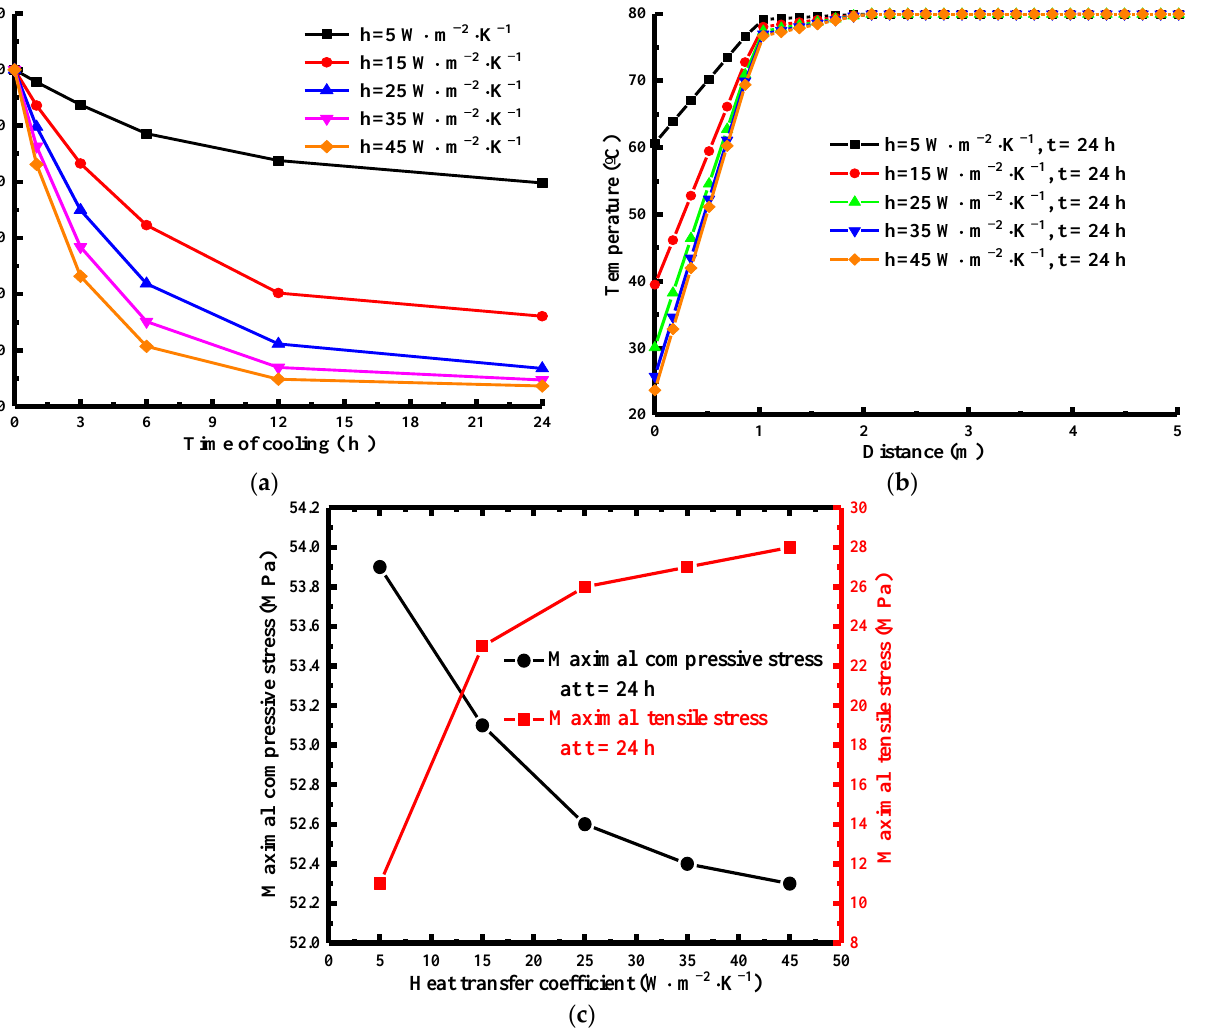
Figure 12. ( a ) Variation in tunnel wall temperature with cooling for 24 h for five heat transfer coefficients; ( b ) internal temperature range of surrounding rock for different heat transfer coefficients at t = 24 h; and ( c ) maximum and minimum stress of surrounding rock for different heat transfer coefficients at t = 24